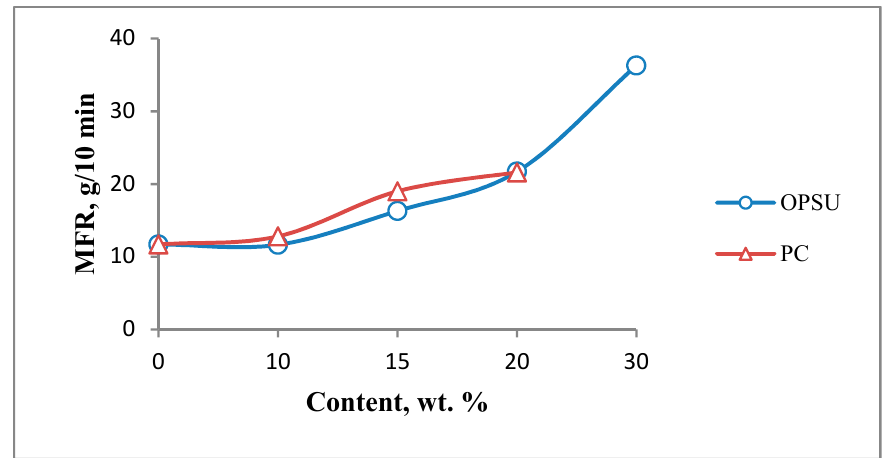
Figure 2. Dependence of melt flow rate polyetherimide (MFR PEI) on the content of oligophenylene sulfone (OPSU) and polycarbonate (PC).